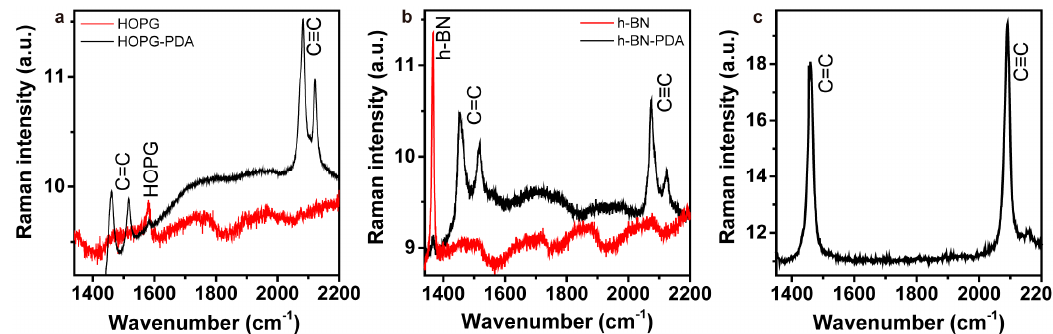
Figure 3. Raman spectra measured on: ( a ) pristine HOPG and HOPG after diacetylene deposition and UV irradiation for 20 min; ( b ) pristine h-BN and h-BN after diacetylene deposition and UV irradiation for 10 s; and ( c ) the diacetylene powder after UV irradiation for 10 s.